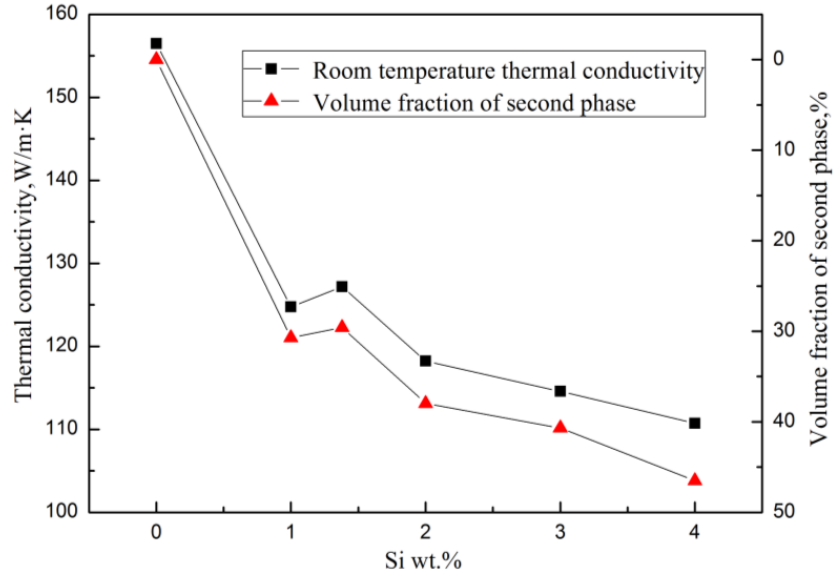
Figure 5. Relationships between room temperature thermal conductivity and volume fraction of the second phase of Mg – xSi alloys with Si content.